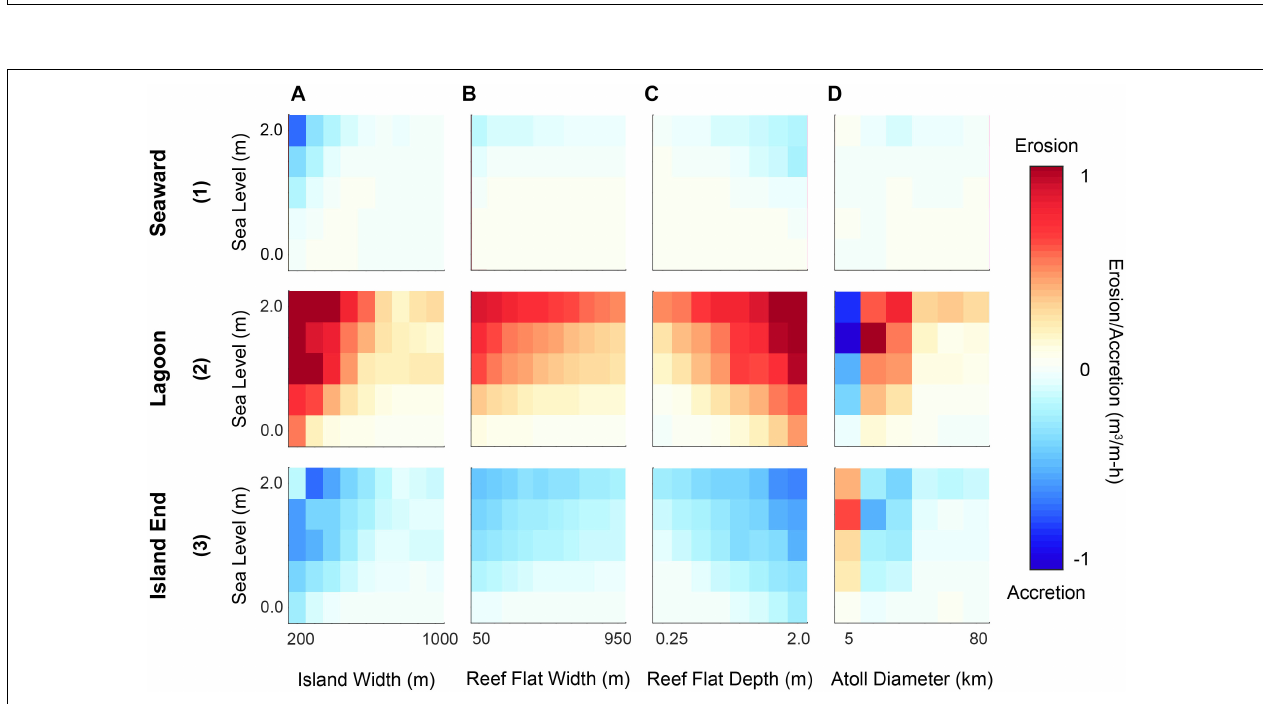
FIGURE 3 | Relative changes in shoreline erosion/accretion magnitudes with morphological parameter (x-axes) and SLR (y-axes) for the leeward island. Rows describe (1) seaward, (2) lagoon, and (3) island end shorelines; columns denote morphological parameters (A) island width, (B) reef flat width, (C) reef flat depth, and (D) atoll diameter. Red indicates net erosion and blue net accretion, with increasing color intensity indicating greater magnitude. The color ramp is linear, but absolute magnitudes are unlisted to address only relative changes.